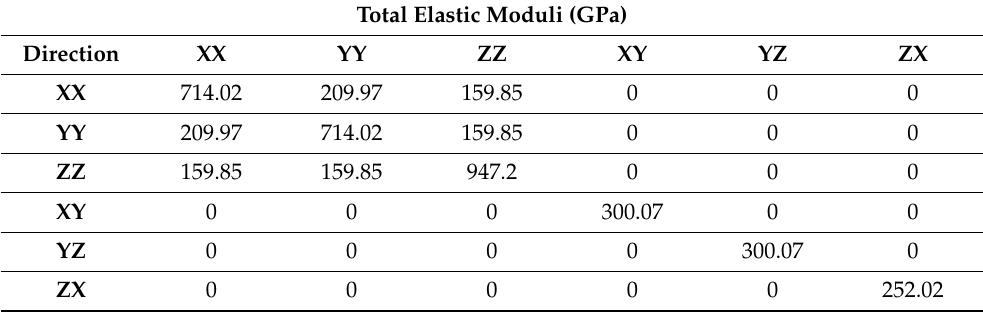
Table 1. Elastic moduli of WC.